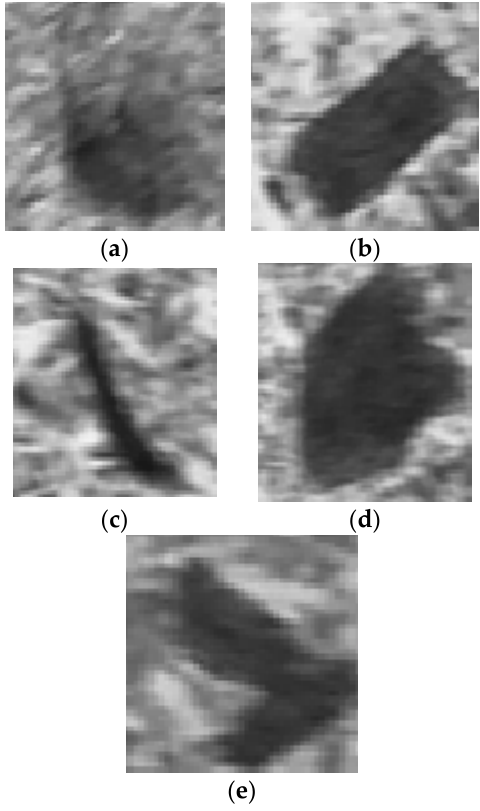
Figure 3. Images of different surface defects: ( a ) subcircular defect; ( b ) subrectangular defect; ( c ) slender defect; ( d ) large defect; ( e ) adjacent defect.